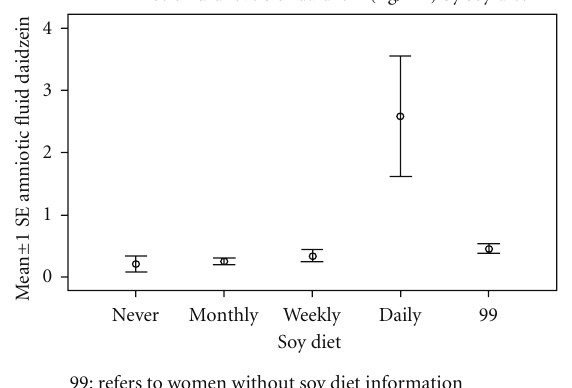
Figure 1: The amniotic fluid levels of Daidzein (ng/mL) by soy diet.